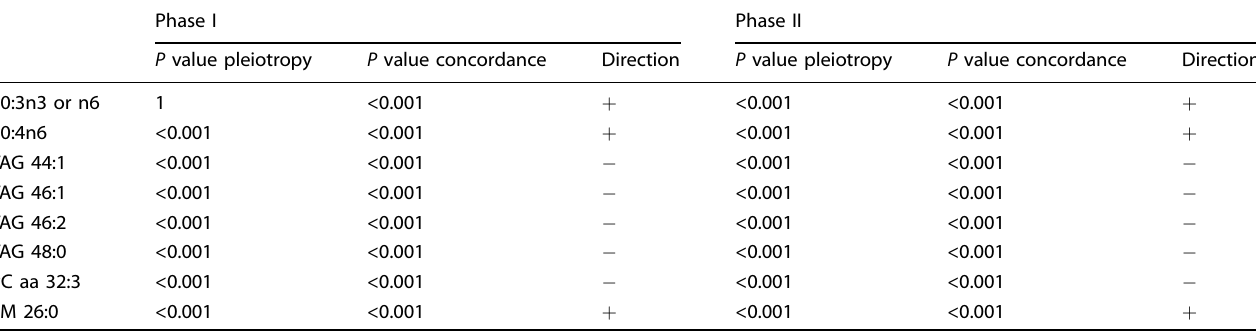
Table 3. Comparison of the pleiotropy and concordance results generated using SNP effect concordance analysis (SECA) for the eight lipids for which we found signi fi cant genetic sharing in both phases I and II. Phase